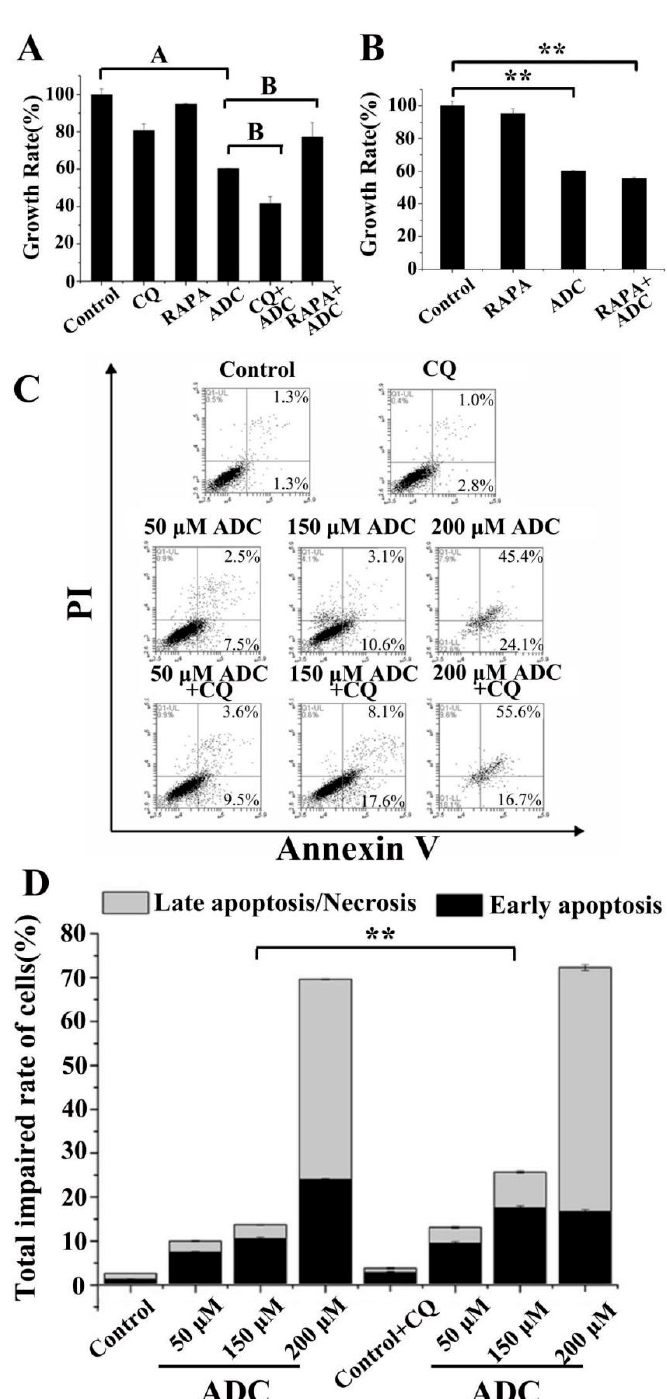
Figure 11. ADC induced protective autophagy. ( A ) Autophagy inhibition was able to protect cells from death. Cells which were pre-treated with ADC were treated with RAPA, and the proliferation rate of cells’ death was detected. A p < 0.01 vs. control; B p < 0.01 vs. ADC. ( B ) Cells were pre-treated with RAPA for 3 h, then treated with ADC for 72 h, and finally the proliferation rate of cells was detected. ** p < 0.01 vs. control. ( C ) Cells were incubated with 50, 150, and 200 μ M ADC for 72 h, and then treated with CQ. The early and late/necrosis apoptotic cells were observed with FCAS after annexin V-FITC/PI double staining. ( D ) The percentage of apoptosis in SPCA-1 was calculated. ** p < 0.01, 150 μ M ADC vs. 150 μ M ADC + CQ (total impaired rate of cells).